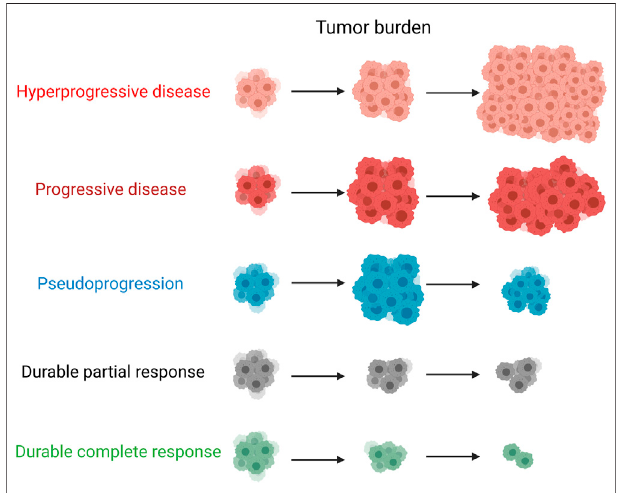
FIGURE 1 | Patterns of response and progression with immune checkpoint inhibitor